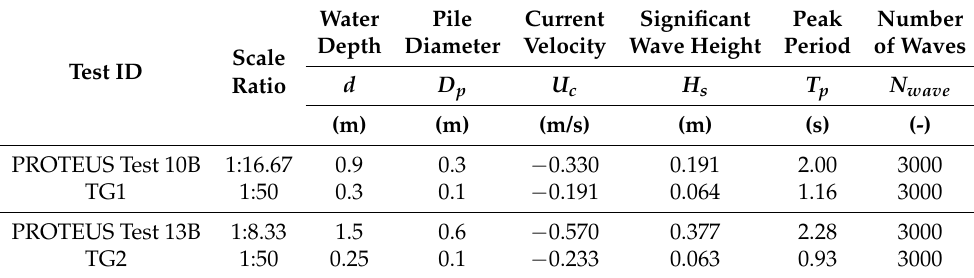
Table 1. Target wave and current conditions of the present tests.